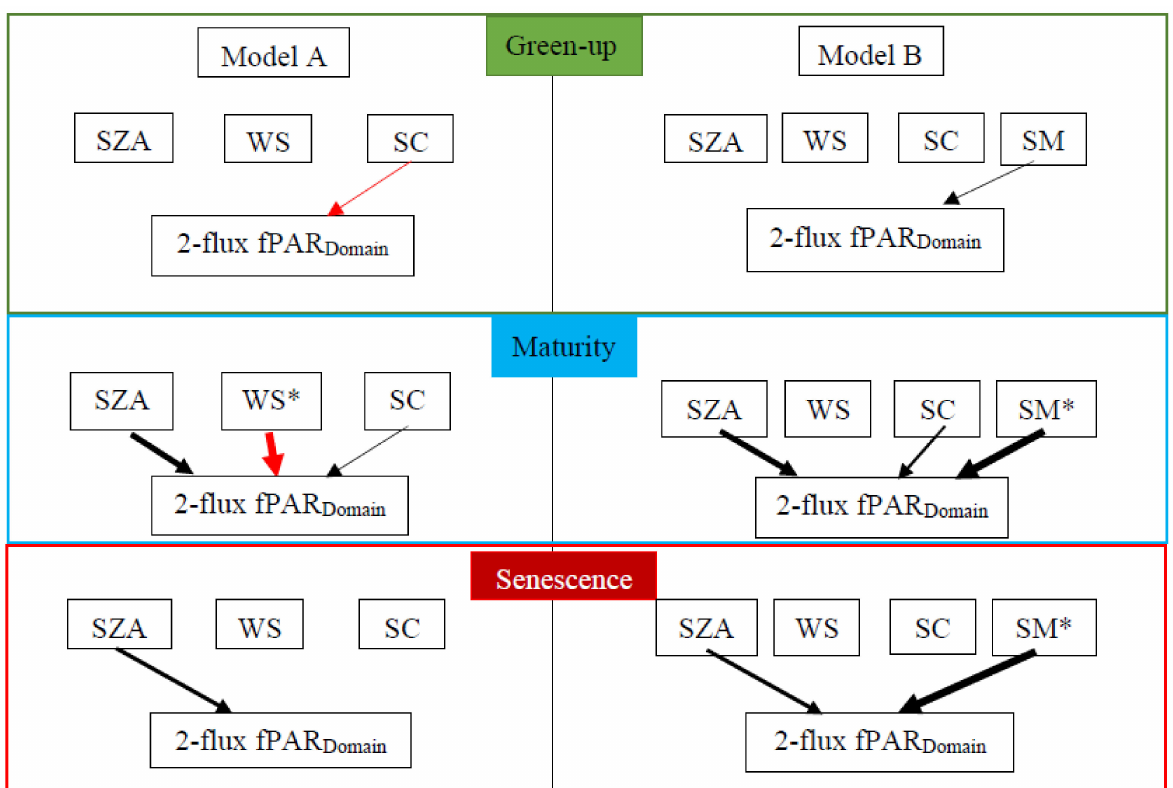
Figure 8. The influence of independent variables on 2-flux fPAR Domain for two GLME models. In every instance, Model B, which included the variable soil moisture (S.M.) had an AIC score half the magnitude of Model A’s. An asterisk (*) indicates those variables with significant ( p < 0.05) influence. Black arrows indicate positive coefficients, red arrows indicate negative coefficients, with the thickness of the arrow indicating the relative effect of the variable, compared to other variables of significance. Arrows associated with variables that do not display the * symbol are variables selected by the stepwise logistic regression but that did not significantly impact the results of the GLME.